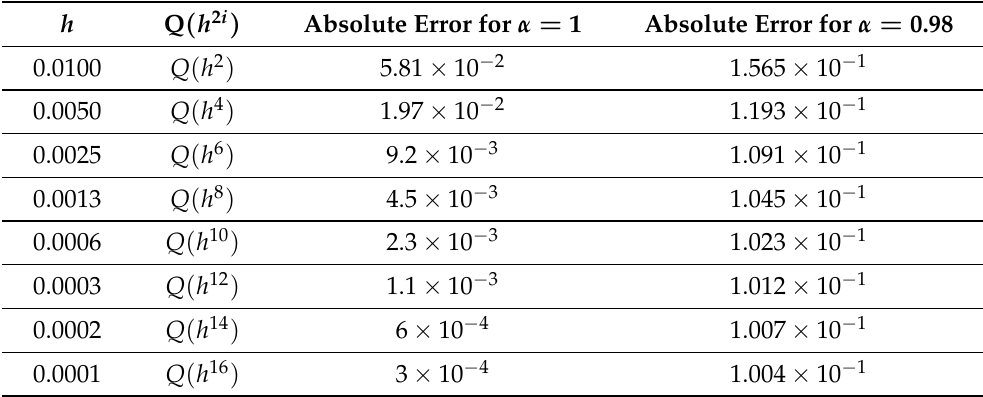
Table 7. The absolute error for Richardson extrapolation between α = 1 and α =